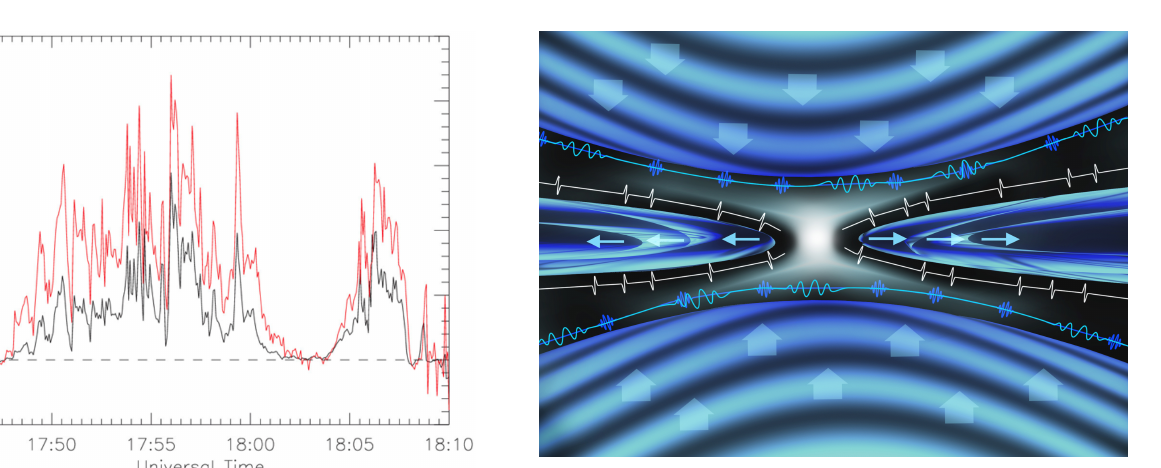
Figure 6. Energy transferred by bursty bulk flows, calculated using two different approaches (from Cao et al., 2013): the red line shows the energy density flux as computed from the data by using the ki- netic approach, and the black line shows the same quantity calcu- lated in the magnetohydrodynamics (MHD) approximation. For this magnetic substorm, the value calculated using the kinetic approach is larger than the value derived from the MHD approximation.